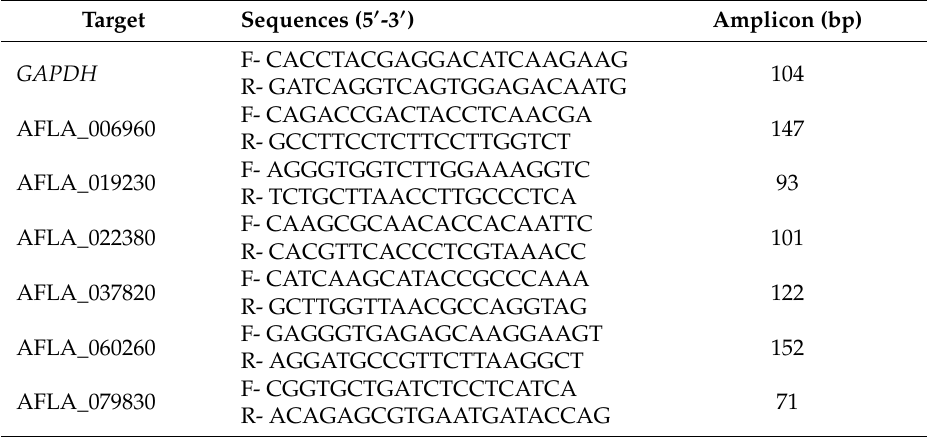
Table 1. Primers used for PCR and